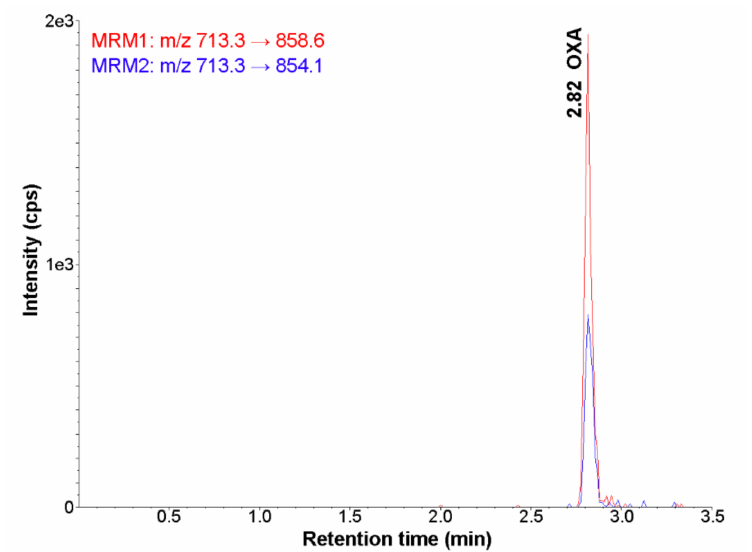
Figure 1. Representative MRM chromatogram of orexin (standard solution at concentration 100 pg/mL) (UHPLC-MS/MS method).